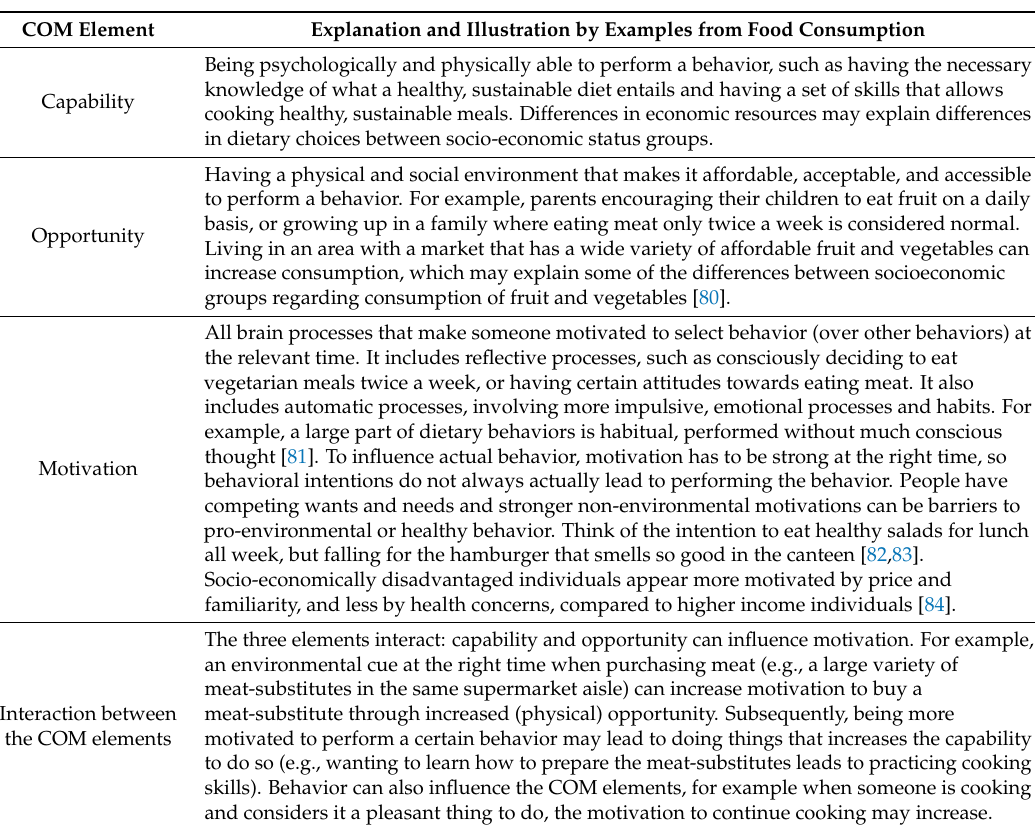
Figure 2. The COM-B system, source: [49]. Figure 2. The COM ‐ B system, source: [49]. Table 2. Explanations of the COM ‐ B elements illustrated by examples from food consumption. Table 2. Explanations of the COM-B elements illustrated by examples from food